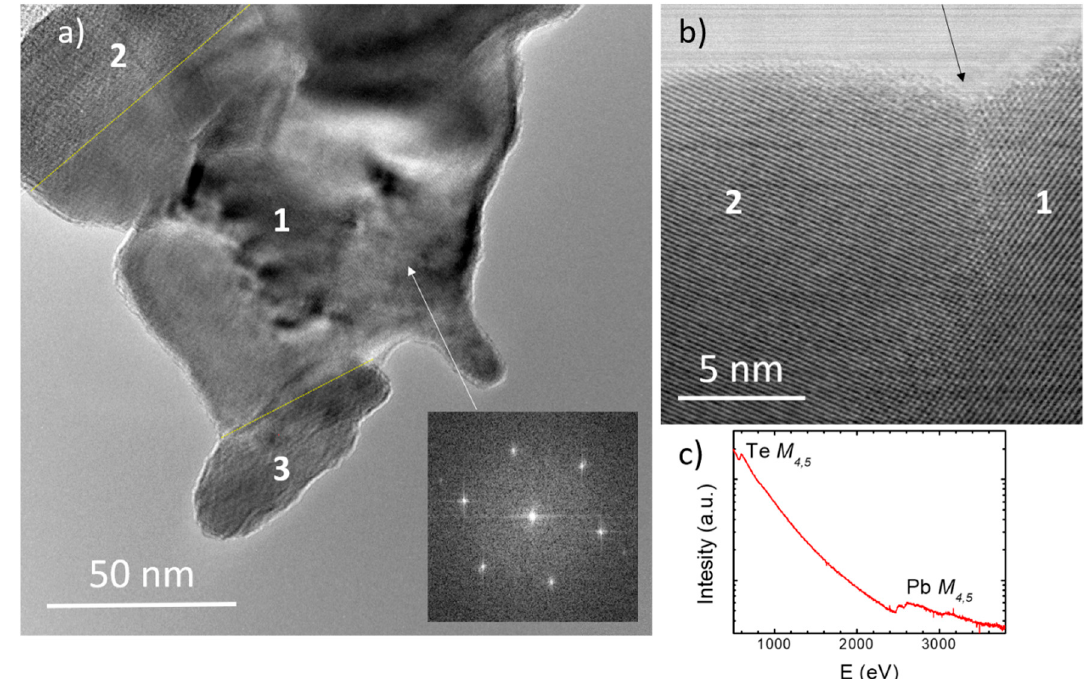
Figure 4. (a) TEM image of a conglomerate consisting of three crystalline grains. The boundaries of different grains are marked by yellow lines. The grain orientations are checked by spatially resolved diffraction patterns, the grain 1 being oriented along the [111] zone axis (inset). ( b ) High magnification image of the boundary between the grains 1 and 2. ( c ) Electron energy loss spectrometer (EELS) spectrum of the conglomerate in this figure. Only Te M 4,5 and Pb M 4,5 edges are detected.